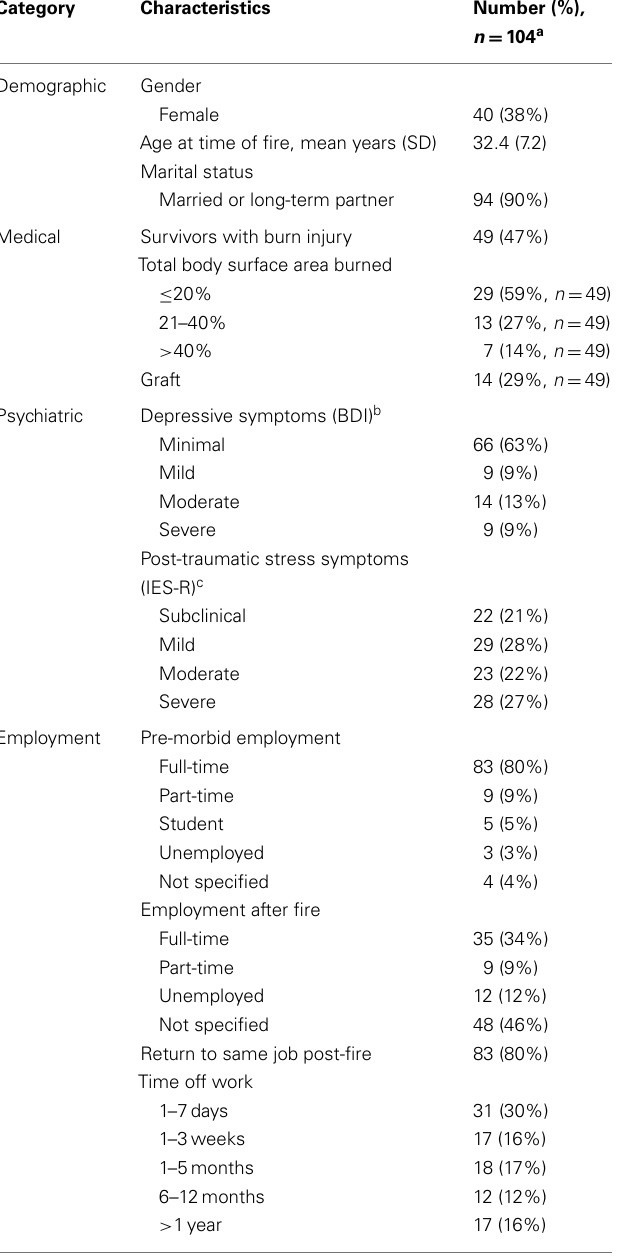
UNIVARIATE AND MULTIVARIATE